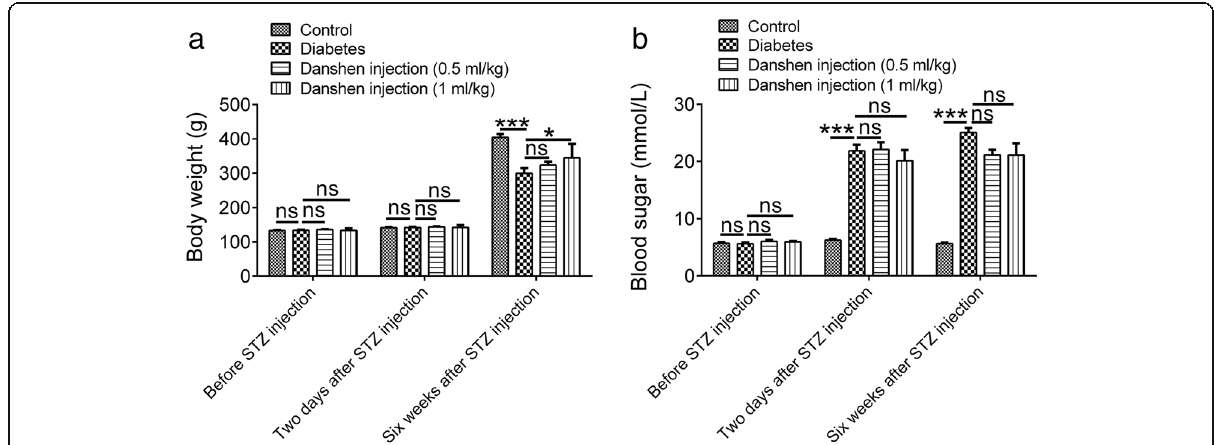
Fig. 1 Danshen injection restored the body weight of diabetic rats without affecting the blood glucose level. a Body weight; b blood glucose levels before and at 2 days and 6 weeks after treatment. Data are presented as the mean ± standard error of the mean (S.E.M.) for ten rats per group. * P < 0.05; *** P < 0.001; ns, not significant